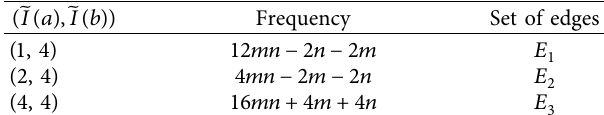
Table 2: Edge partition of TbO